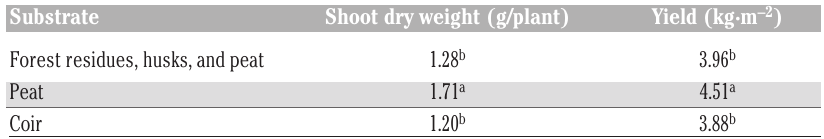
Table 3. Effects of three commercial substrates on shoot dry weight and fresh yield of spinach.